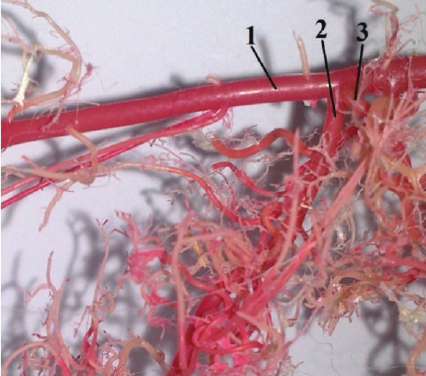
Figure 8: Photograph demonstrating the origin of a. mesenterica cranialis caudal to the a. renalis dextra . 1: aorta abdominalis , 2: a. mesenterica cranialis , and 3: a. renalis dextra (casting medium Duracryl